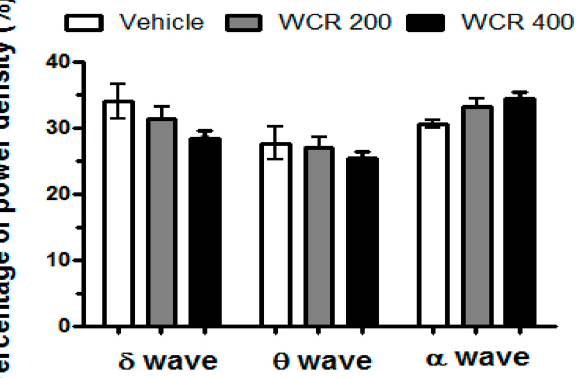
Figure 7. Effects of WCR on the EEG power during NREM sleep. The EEG power densities during delta, theta, and alpha wave activities for NREM sleep were measured. The data displays the mean ± SEM of the EEG power density in three selected frequency bands in the NREM sleep stage. The CON group: treatment with the vehicle; the WCR groups: treatment with WCR (200 or 400